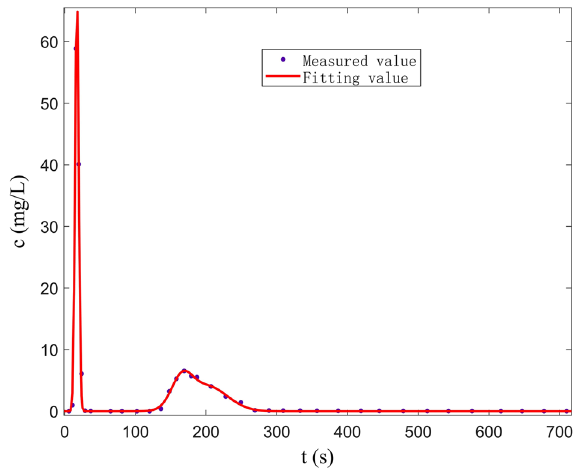
Figure 16. Curve fitted by Gauss multi-peaks method (F 1 -C 2 -D 2 ).